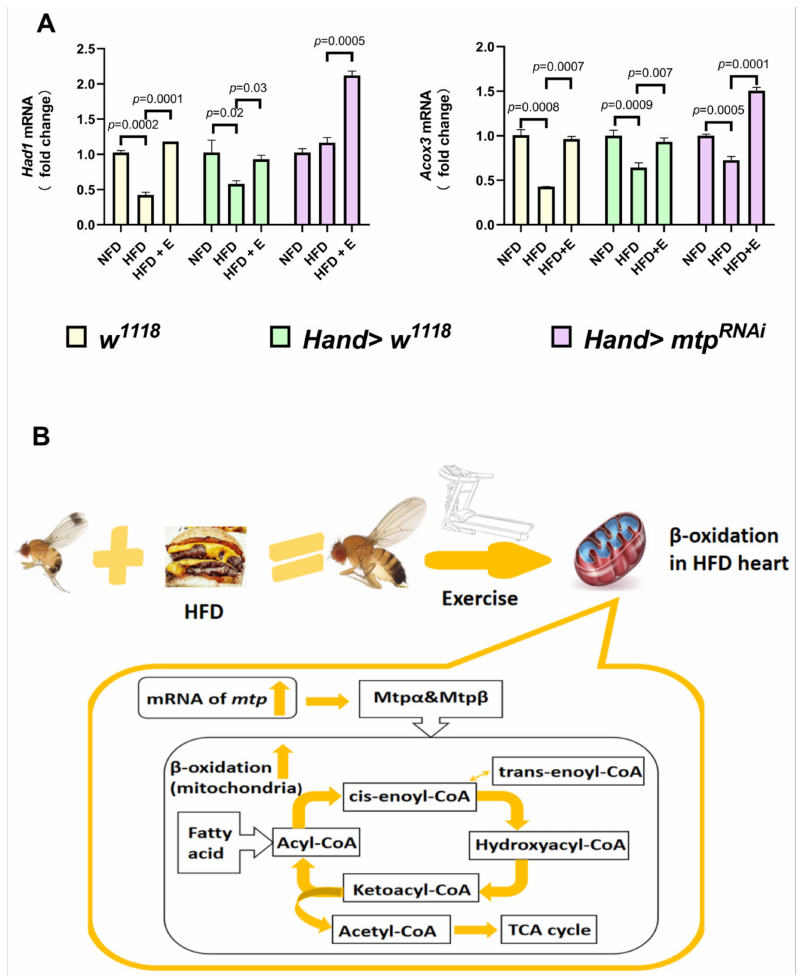
Figure 7. ( A ) Comparison of the expression levels of Had1 and Acox3mRNA in w 1118 , Hand > w 1118, and Hand > mtp RNAi hearts under different treatments using one-way ANOVA with LSD for post hoc testing. Compared to the NFD groups, Had1 expression was decreased in HFD + w 1118 and HFD + Hand > w 1118 Drosophila cardiomyocytes, while Acox3 expression was decreased in HFD + w 1118 , HFD + Hand > w 1118 and HFD + Hand > mtp RNAi Drosophila cardiomyocytes. Compared with the HFD groups, there was a general increase in Had1 and Acox3 in w 1118 , Hand > w 1118, and Hand > mtp RNAi Drosophila cardiomyocytes after exercise training. All samples were virgin flies of 10 days (N = 50 per group). ( B ) Putative role of mtp in β -oxidation in the heart stimulated by exercise